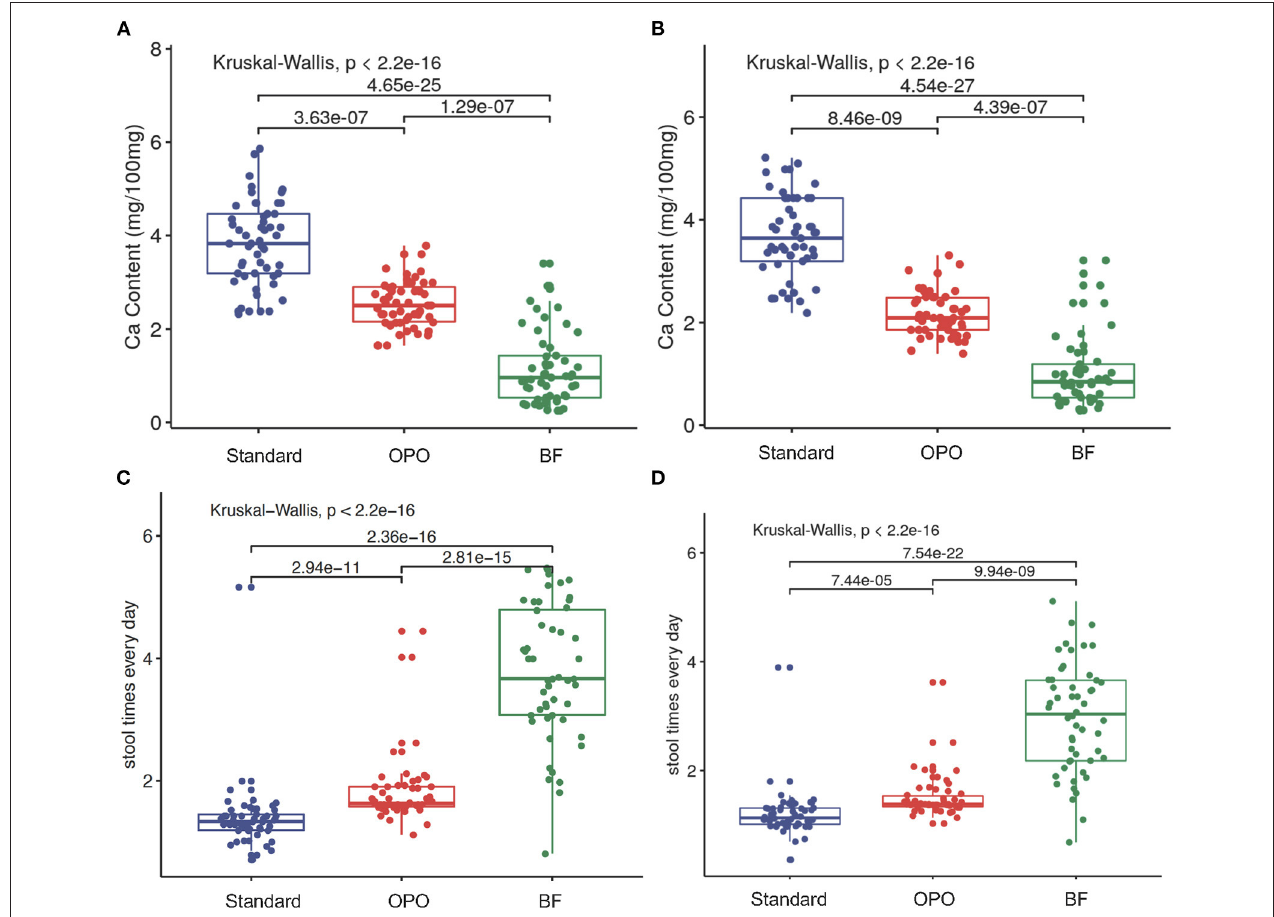
FIGURE 5 | Stool characteristics after feeding. (A,B) Comparison of stool calcium concentrations of the three feeding groups at week 6 and week 12. (C,D) Comparison of stool frequency per day of the three feeding groups within 6 weeks and within 12 weeks. Data are presented as the mean (range). A p -value of less than 0.05 was considered statistically